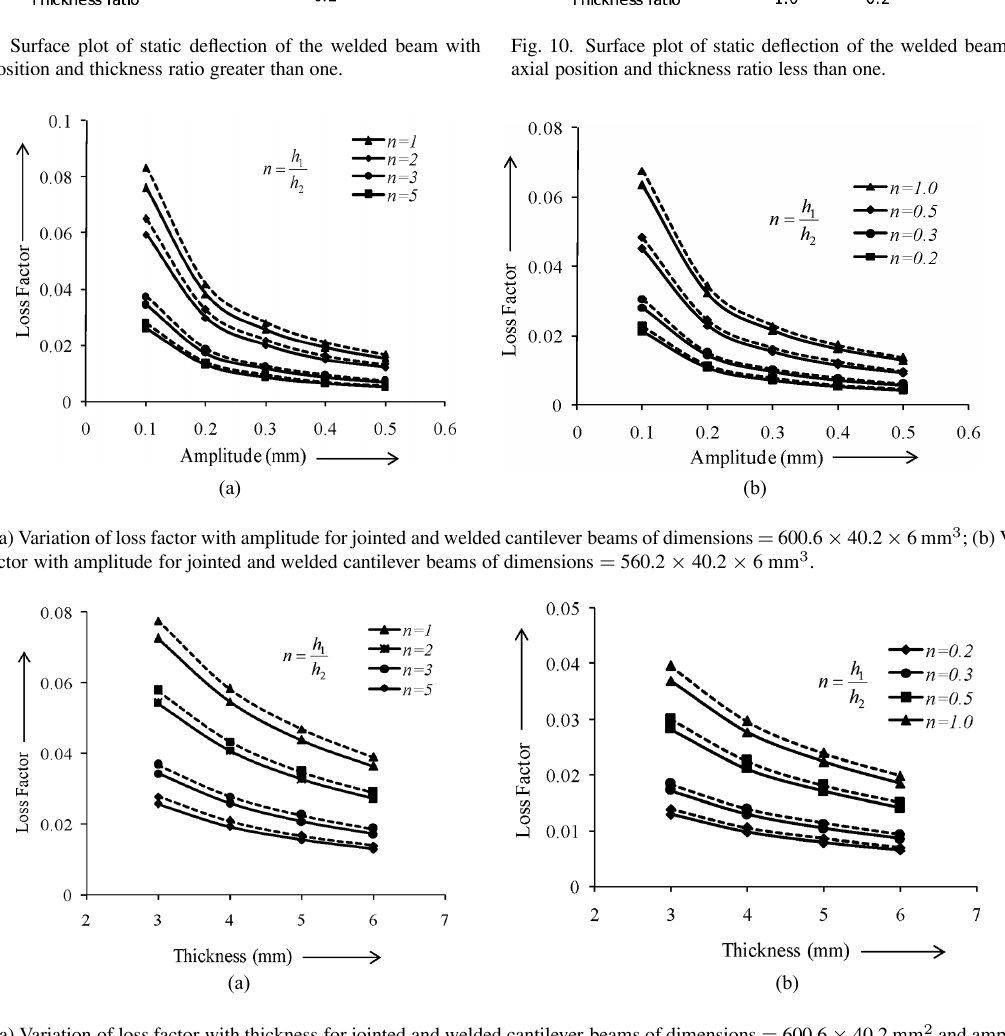
Fig. 12. (a) Variation of loss factor with thickness for jointed and welded cantilever beams of dimensions = 600.6 × 40.2 mm 2 and amplitude = 0.1 mm; (b) Variation of loss factor with thickness for jointed and welded cantilever beams of dimensions = 560.2 × 40.2 mm 2 and amplitude = 0.2